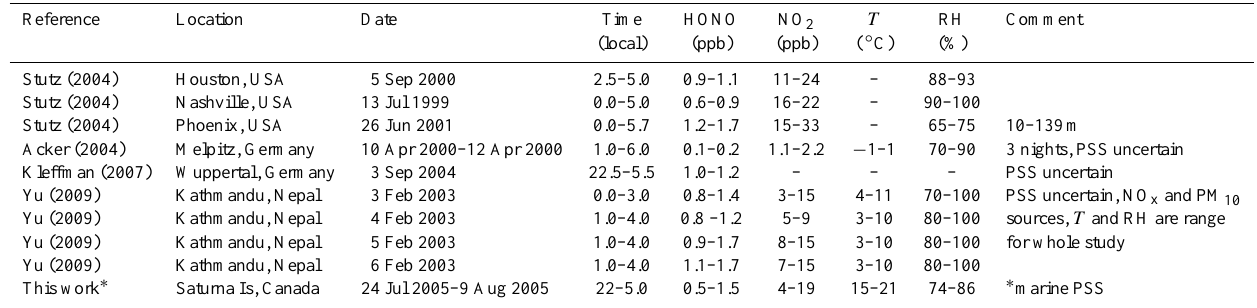
Table 2. Evidence of nocturnal HONO pseudo steady states in terrestrial locations.